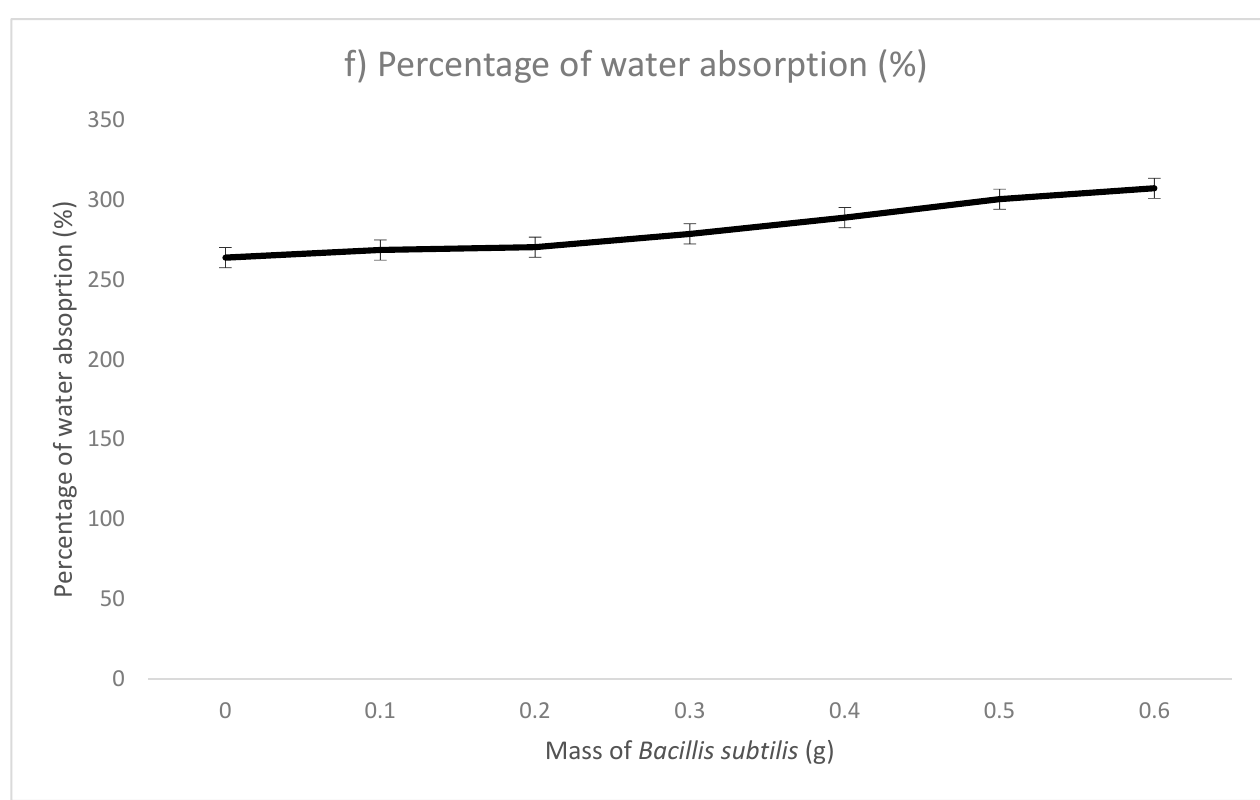
Figure 4. Graphs of ( a ) thickness, ( b ) opacity (white light), ( c ) opacity (black light), ( d ) brightness, ( e ) conductivity and ( f ) water absorption of microbial composite films. ( N = 3). Table 2. Thickness (mm), opacity (white light and black light, %), brightness (%), conductivity and water absorption (%) and scanning electron microscopy (SEM) of sodium alginate film and microbial composite films.